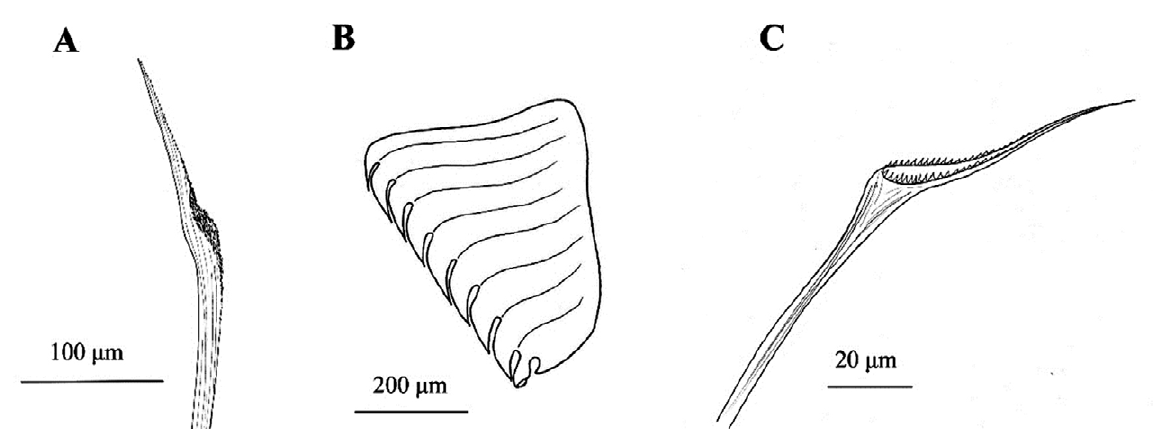
Fig. 6. – Chaetae of Spirobranchus cf. tetraceros from Valencia Port. A, Spirobranchus -type collar chaetae; B, thoracic uncini; C, true trumpet-shaped abdominal